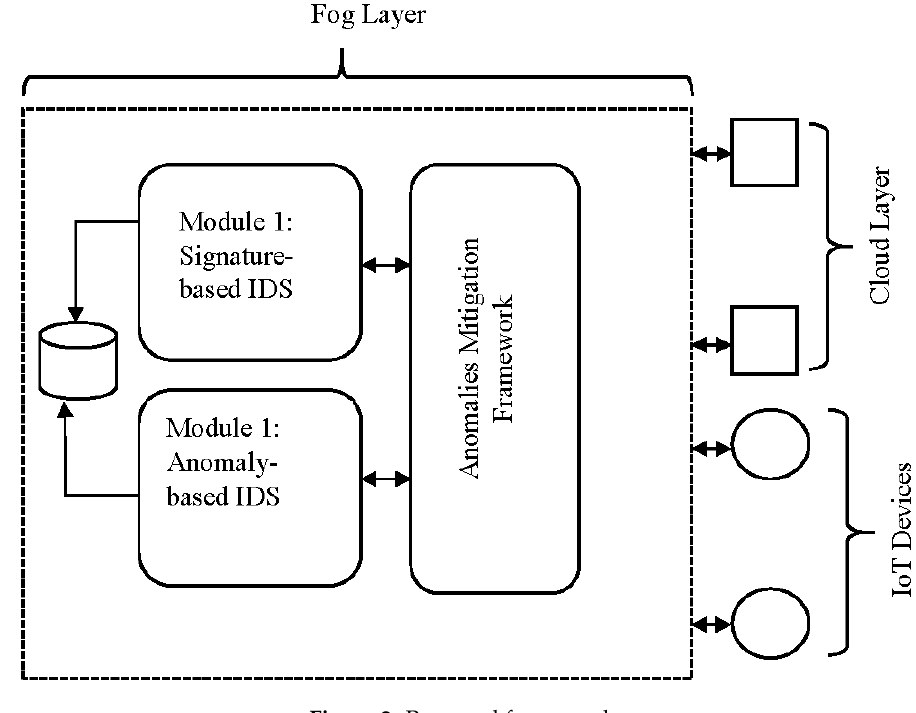
Figure 2. Proposed framework.